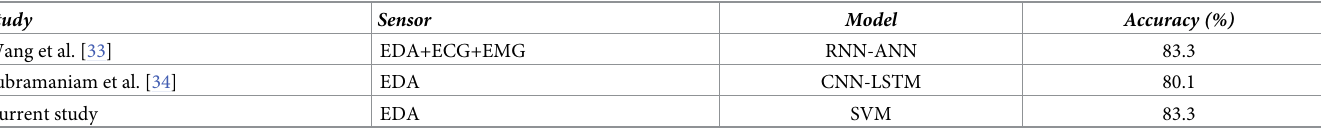
Table 5. Comparing P0 vs P04 subject-independent binary classification task in the literature.